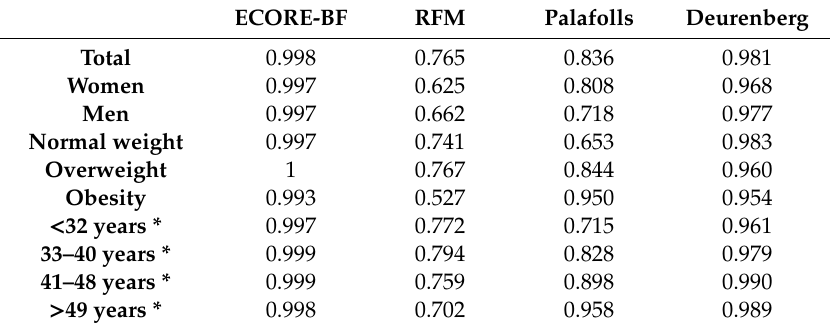
Table 4. Lin’s concordance correlation coe ffi cient between study formulas and CUN-BAE. ECORE-BF RFM Palafolls